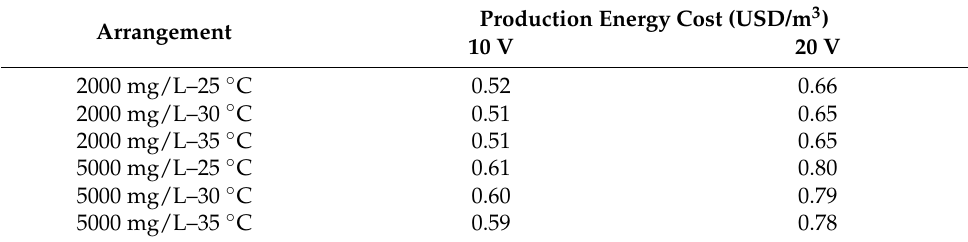
Table 11. Energy cost per cubic meter of